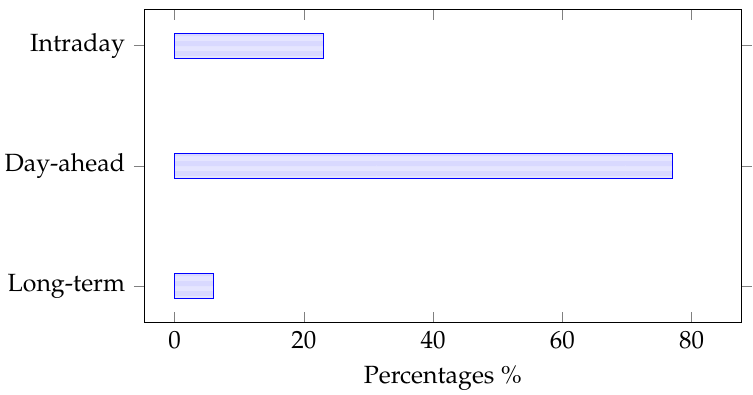
Figure 6. Share of the reviewed literature that considered ESS operational models at three timescales: intraday, day-ahead and